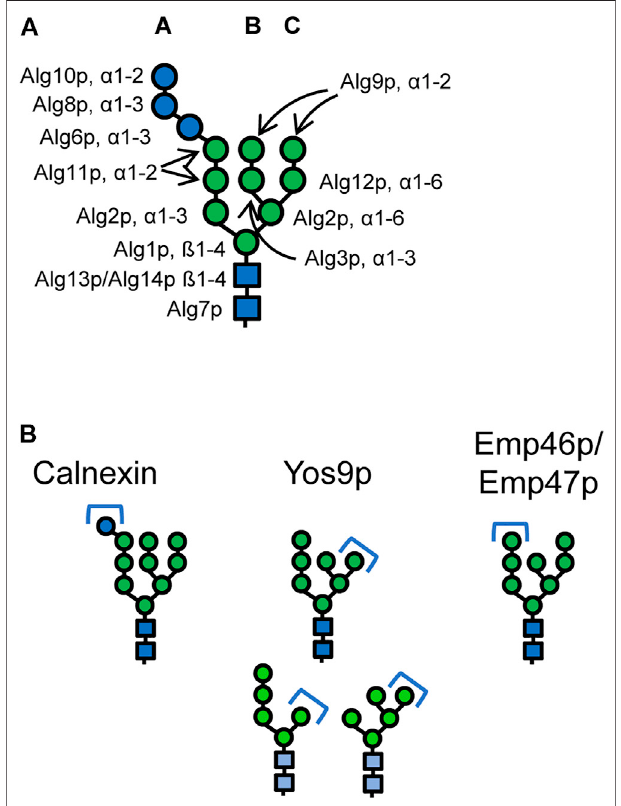
FIGURE 1 | (A) Structure of the eukaryotic dolichol-linked oligosaccharide. Linkages and the names of the enzymes catalysing the respective steps are given. Deletion of ALG11 gene prevents formation of the A-branch. Deletion of ALG3 gene prevents formation the B- and C-branch mainly generating a Man 5 GlcNAc 2 structure. Glucosylation of the A-branchisimpaired in Δ alg3 mutants. (B) CanonicalN-glycanstructuresthat mediate binding to the lectins calnexin/calreticulin, the ERAD lectin Yos9p, and the ER export receptors Emp46p/Emp47p, respectively. Alternative Yos9p substrates are marked in lighter hues. Blue circles: glucose, green circles: mannose, blue squares: N-acetylglucosamine.